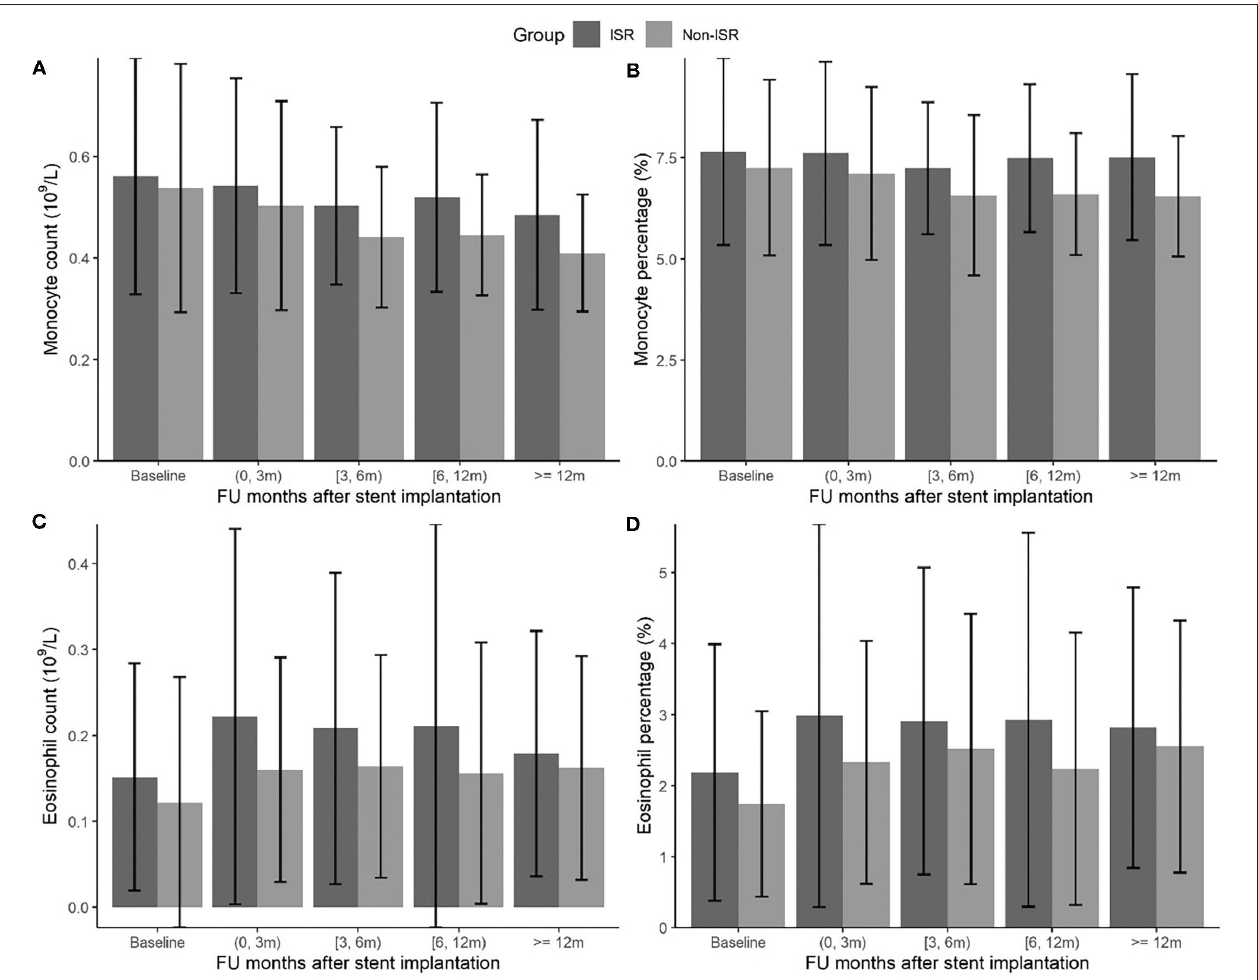
FIGURE 1 | The changes of monocyte and eosinophil count (10 9 /L) (A,C) and percentage (%) (B,D) during the follow-up months between ISR and non-ISR